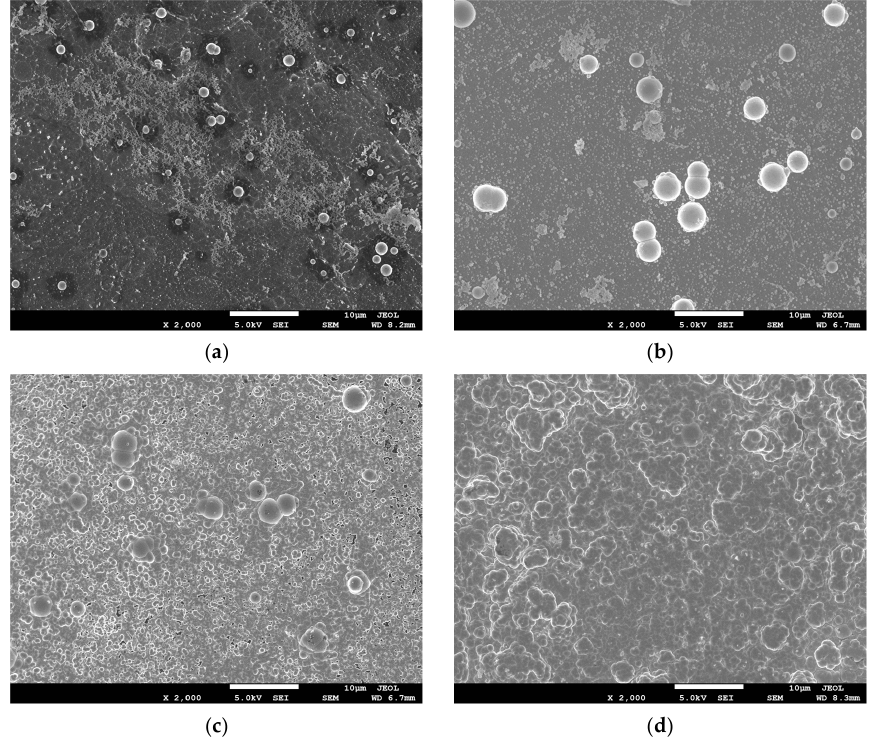
Figure 6. The evolution of the optimized upper surface morphology of the Mg–Li alloy with reaction time: ( a ) 2 min, ( b ) 10 min, ( c ) 20 min, ( d ) 45 min.